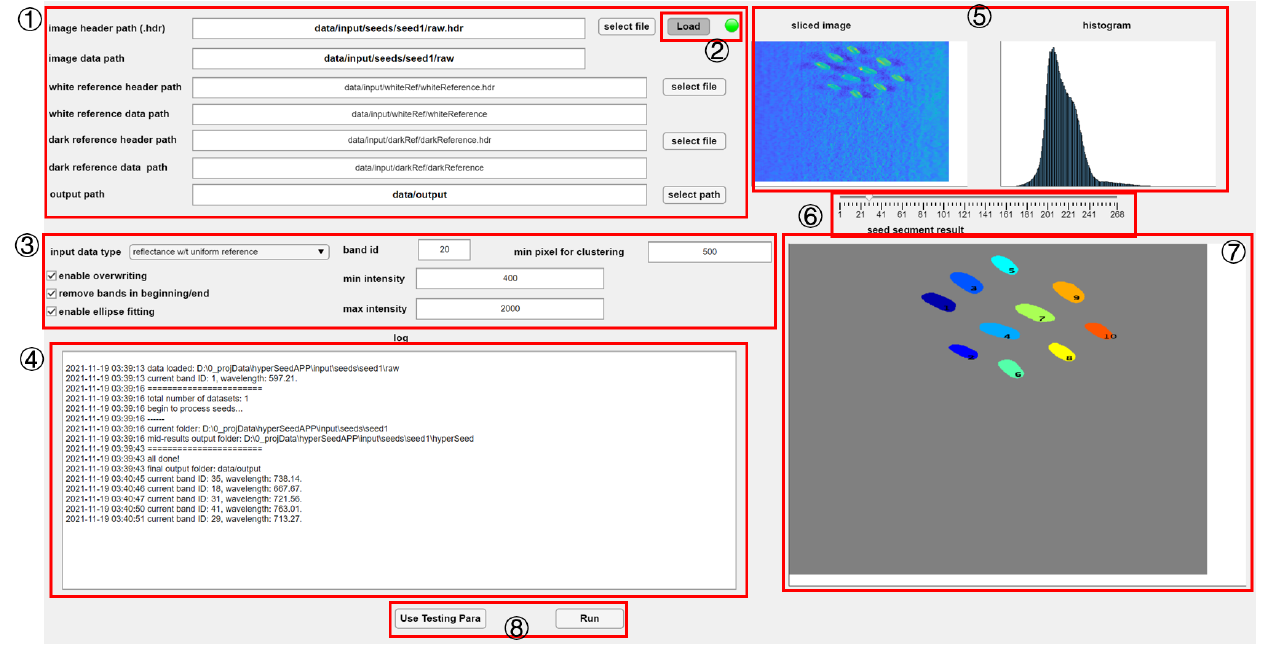
Figure 3. The GUI of HyperSeed software: (1) path region to define the path for input and output files; (2) loading region to load the dataset of interest for visualization; (3) setting region for parameter setting; (4) log region to display progress information; (5) visualization region for the sliced image and the corresponding histogram; (6) slider to specify wavelength for visualization; (7) visualization region for segmentation results; (8) buttons for initiating the image